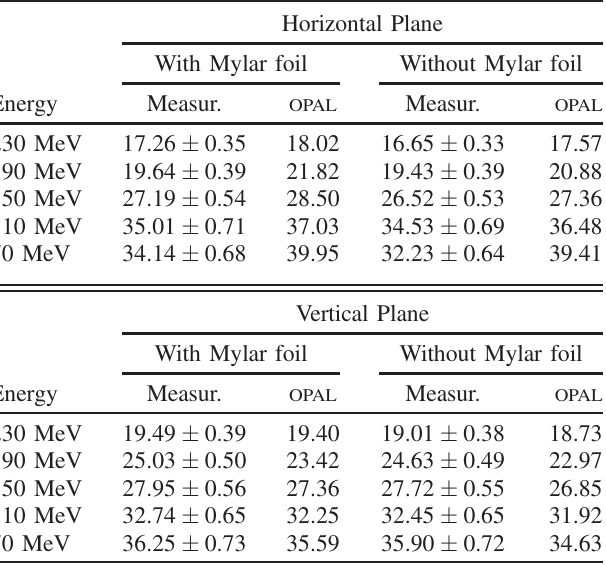
verse unnormalized total emittances ( π mm mrad) with and without the Mylar